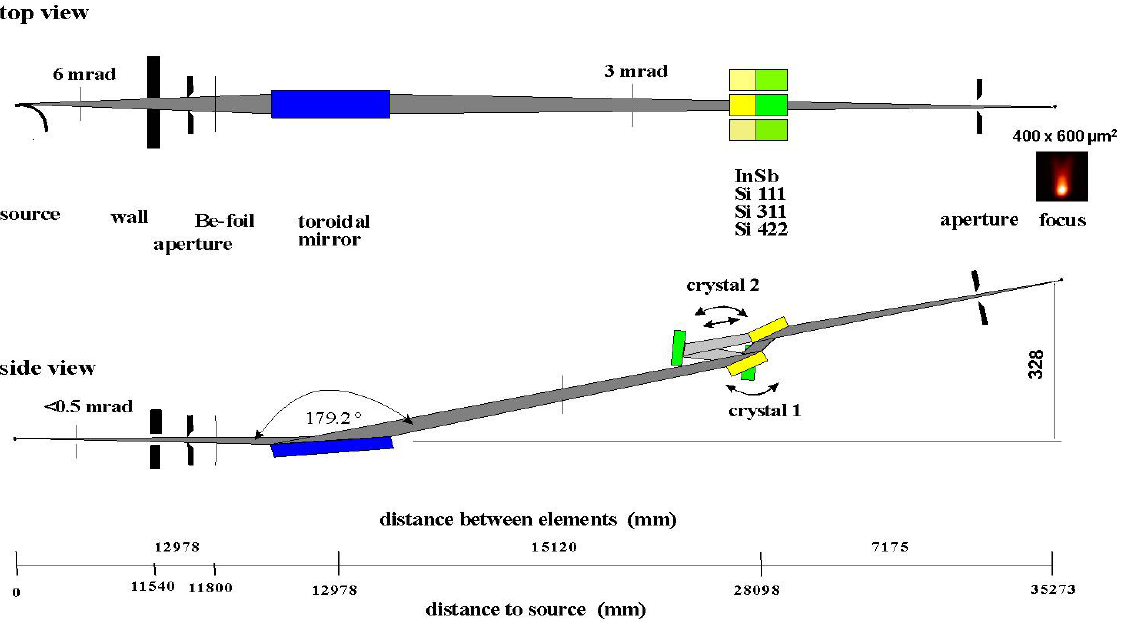
Figure 2: Optical layout of beamline KMC-1.